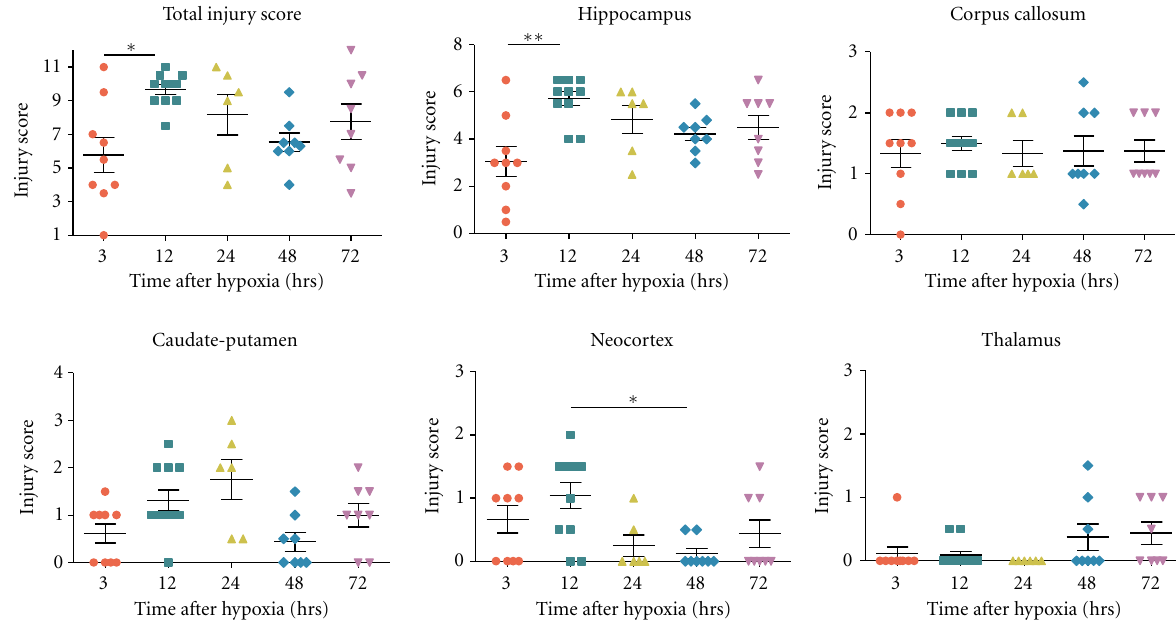
Figure 3: Graphs showing the changes in the total injury score along with the injury score in di ff erent regions analyzed after 3 to 72 hours (hrs) after hypoxia in Nissl-stained coronal sections. Kruskal Wallis test was done followed by Dunn’s multiple comparison test. ∗ P < 0 . 05, ∗∗ P < 0 . 01 was considered